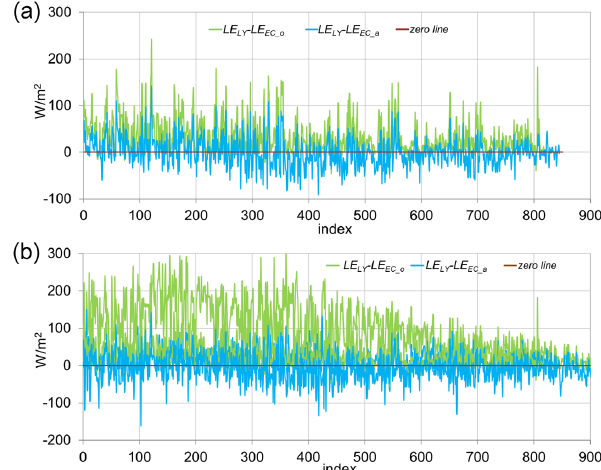
Figure 9. (a) EC deviations from LY observations before (green) and after (blue) EC adjustments along observation period for sta- tion F2. (b) EC deviations from the LY observations before (green) and after (blue) EC adjustments along observation period for station